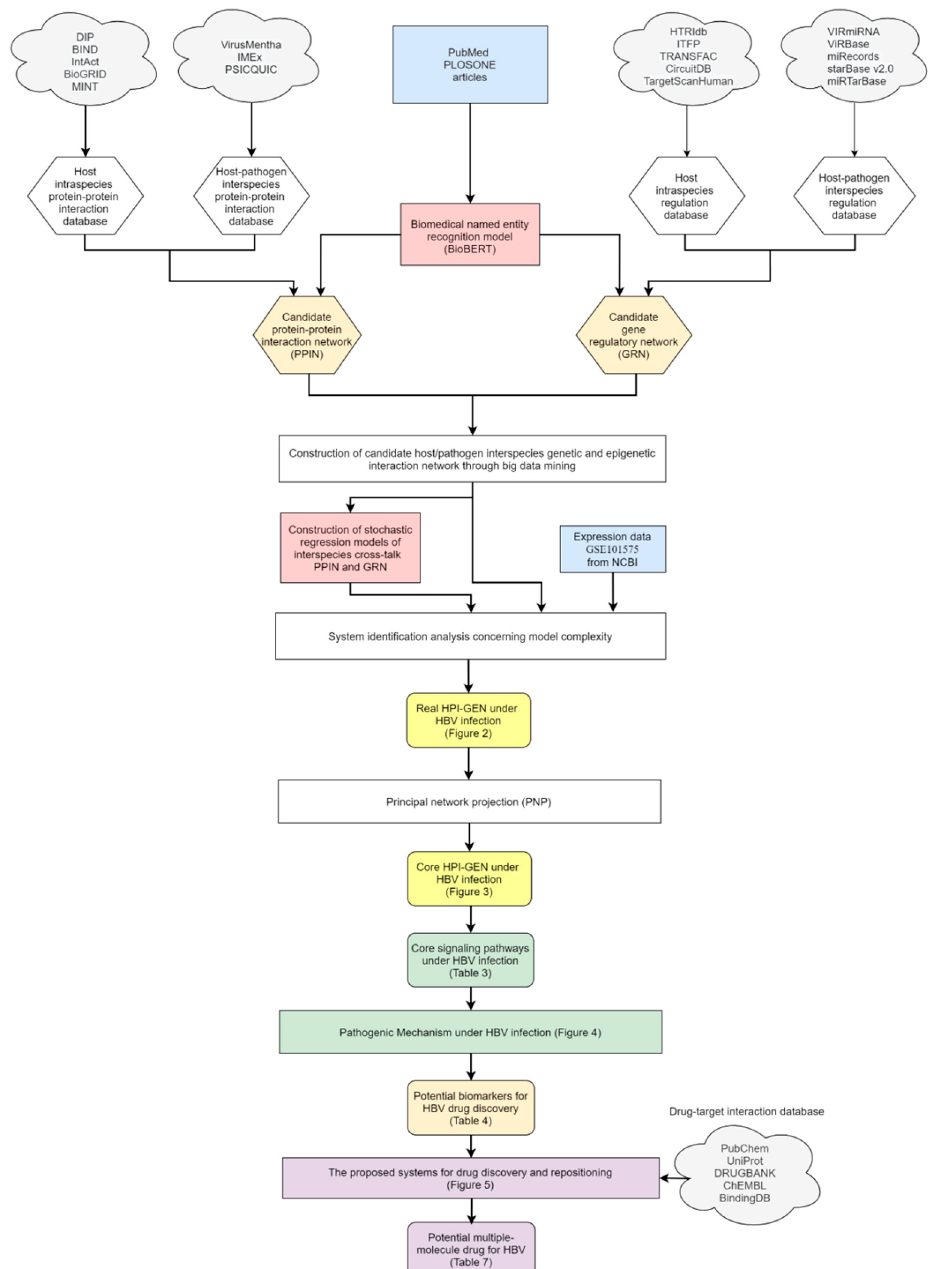
Figure 1. Flowchart of applying systems biology method to construct the candidate HPI-GEN, real HPI-GEN, core HPI-GEN, and core signaling pathways during the infection of HBV to identify the potential biomarker for later drug discovery repurposing. The grey blocks in the shape of a cloud indicate the online databases for constructing candidate HPI-GEN and later drug repositioning; the white diamond blocks are the corresponding data types of each database; the orange diamond blocks signify candidate protein-protein interaction network (PPIN) and gene regelation network (GRN); the blue blocks represent the input information including the raw RNA-seq data for system identification and the collected articles for BioBERT to augment the interspecies interactions and regulations in PPIN and GRN, respectively; the red blocks denote the models comprising BioBERT and stochastic regression models utilized in the systems biology approach; the white rectangle blocks indicate the systematic methods applied to constructing the candidate HPI-GEN and extracting core HPI-GEN; the purple blocks imply the drug discovery and repositioning procedure proposed afterwards; and the yellow rounded rectangular blocks are the real HPI-GEN and core HPI-GEN during the infection of